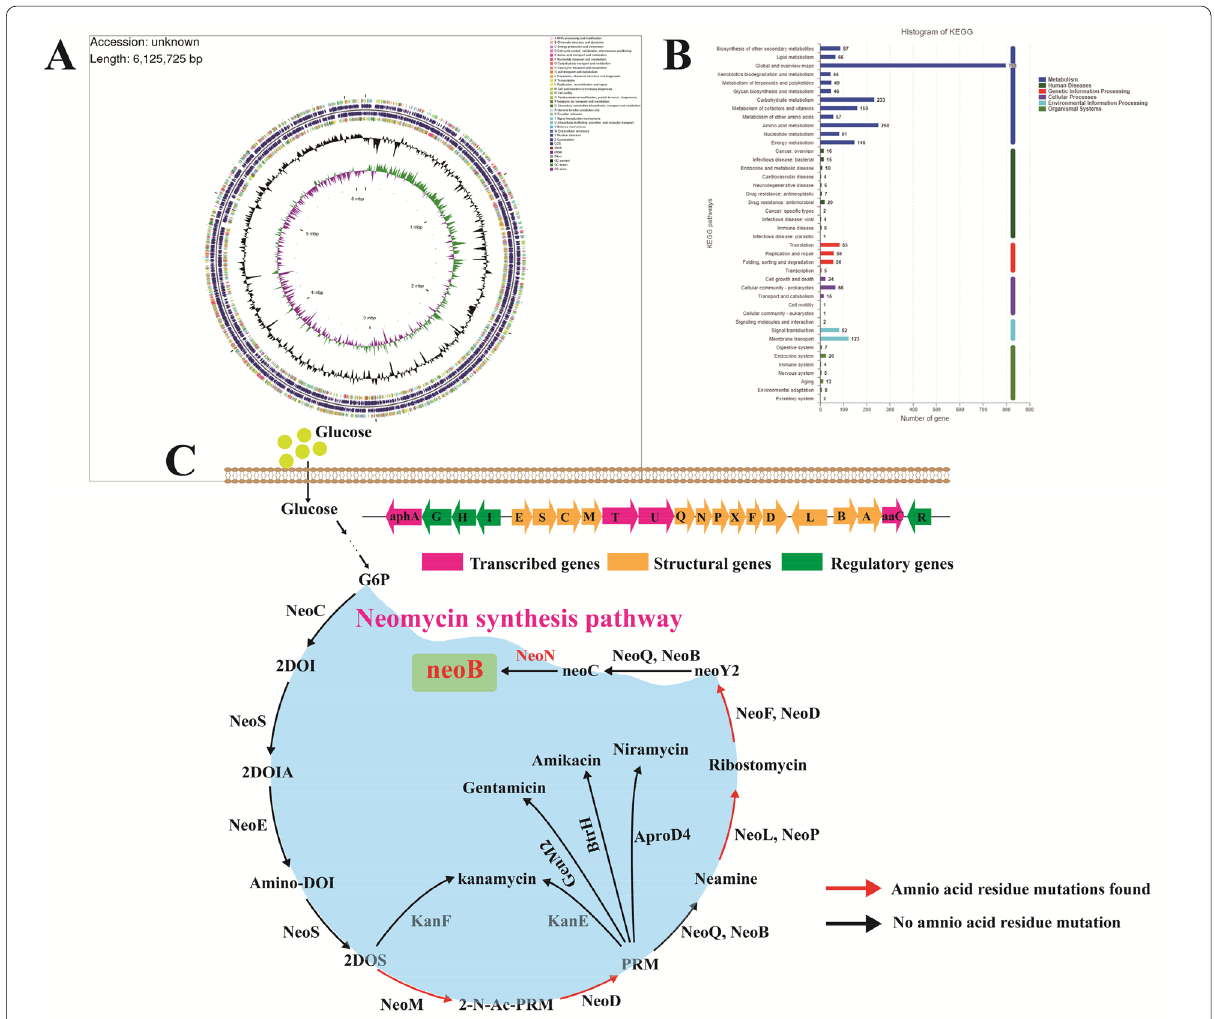
Fig. 2 Whole-genome sequencing of strain SF-2. A Circos loop map of strain SF-2. B Classification of KEGG metabolic pathway of strain SF-2. C Neomycin biosynthesis gene cluster of strain